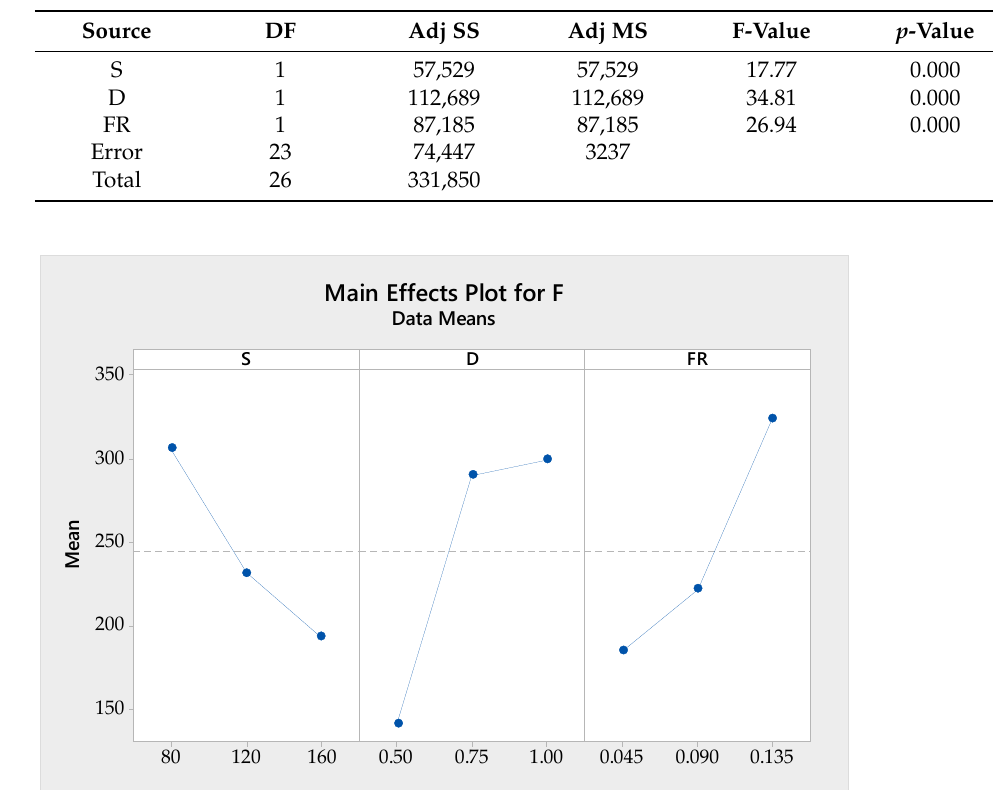
Table 9. ANOVA results for F using wiper cutting edge.